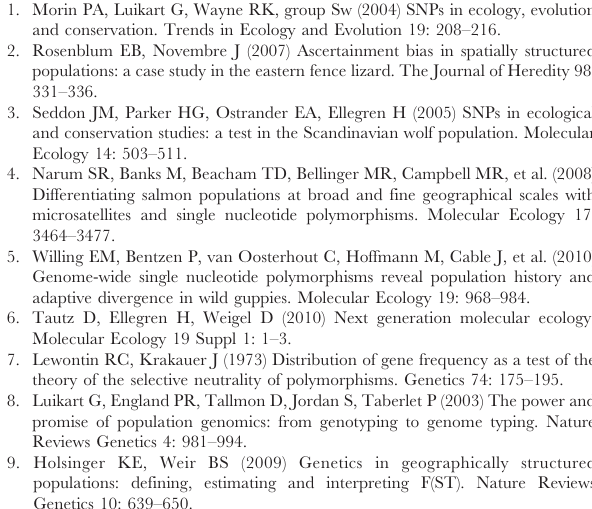
Table S1 F ST estimates according to Wright (1951). (XLSX) Table S2 F ST estimates according to Weir & Cockerham (1984). (XLSX) Table S3 F ST estimates according to Reich et al. (2009).